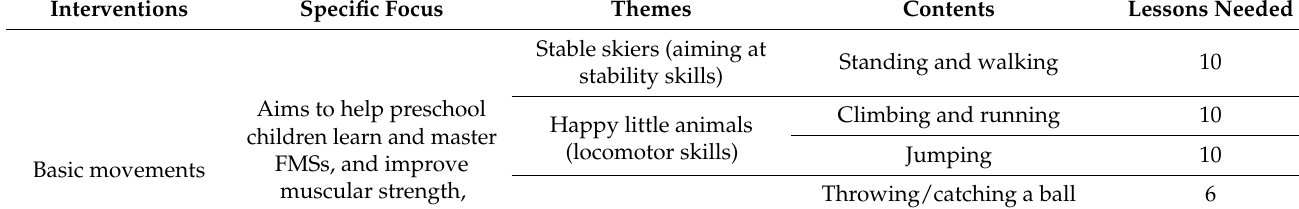
Table 1. Description of the contents, specific focus, and time allocation of the four